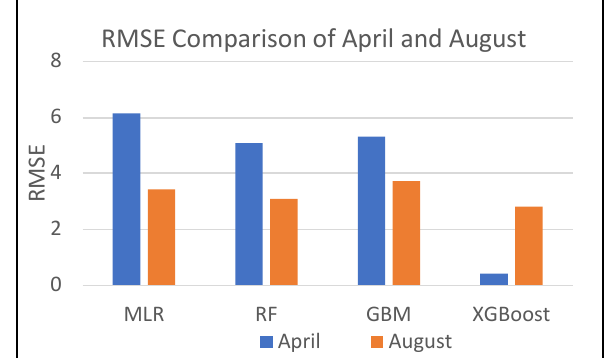
Figure 9. RMSE Comparison of April and August